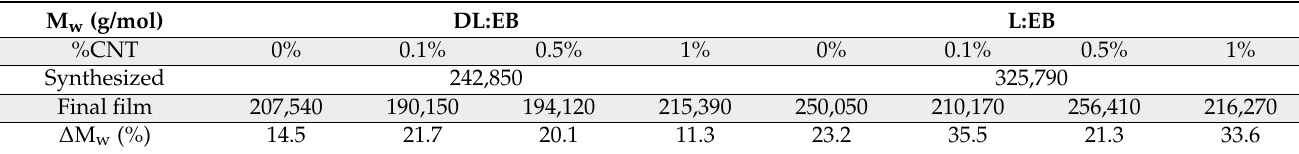
Table 2. Molecular weights of the resulting films after their processing and incorporation of